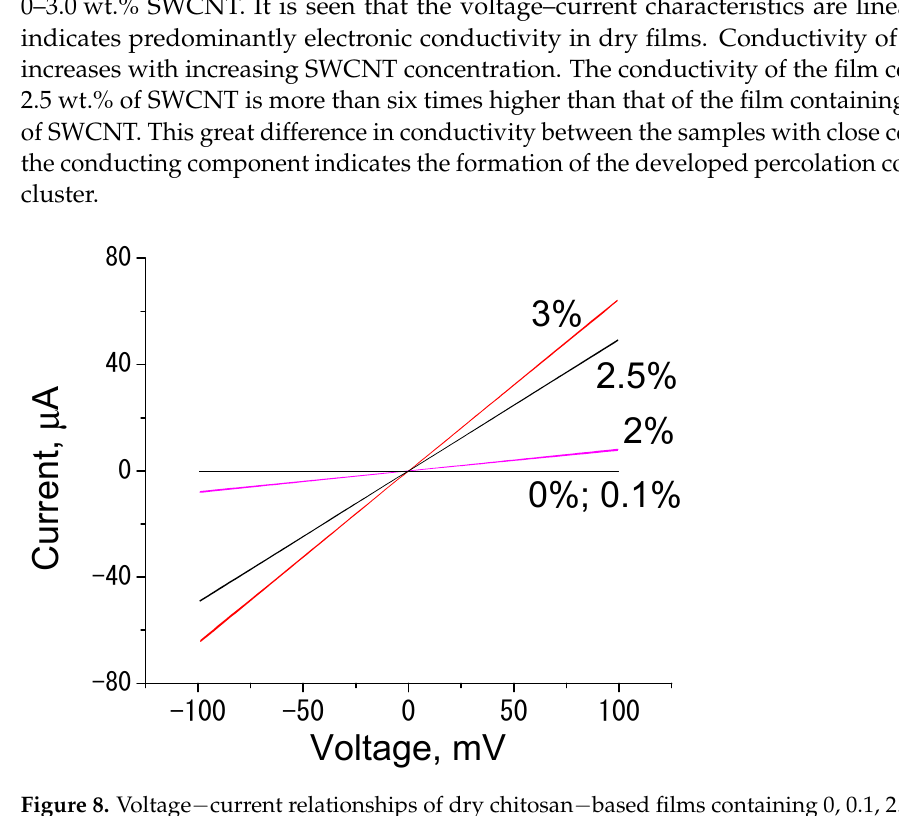
( b ) Figure 9. Current sweeps for the chitosan/SWCNT composite films measured in the dry state (red) and in physiological solution (blue). The SWCNT contents: 2.0 wt.% ( a ), 2.5 wt.% ( b ). The changes in the character of electric current in physiological solution are caused by the appearance of ionic charge carriers in the sample and the formation of a double